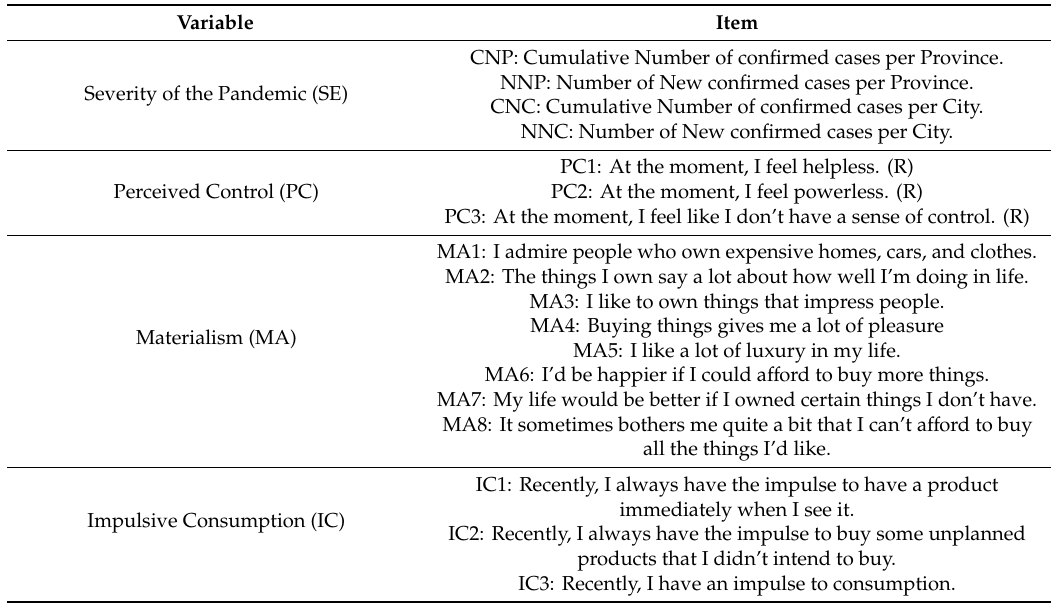
Table 2. Items of the